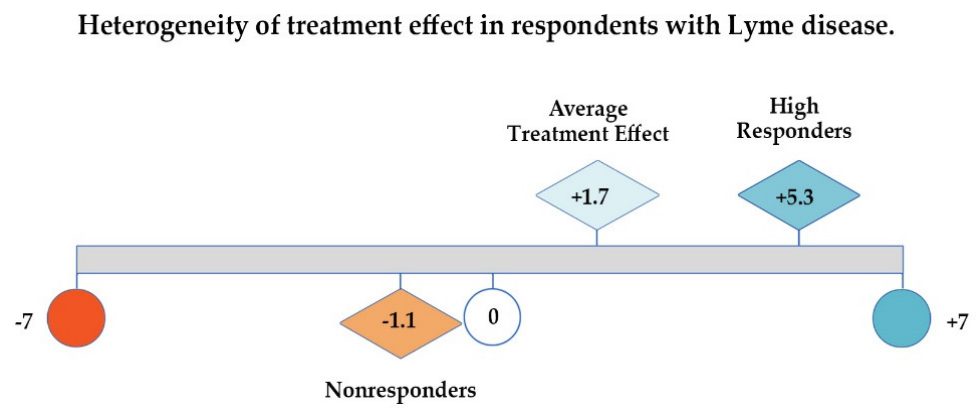
Figure 3. Average treatment effect, high responders, and nonresponders on global rating of change (GROC) scale shows heterogeneous treatment response among participants that average treatment effect masks.